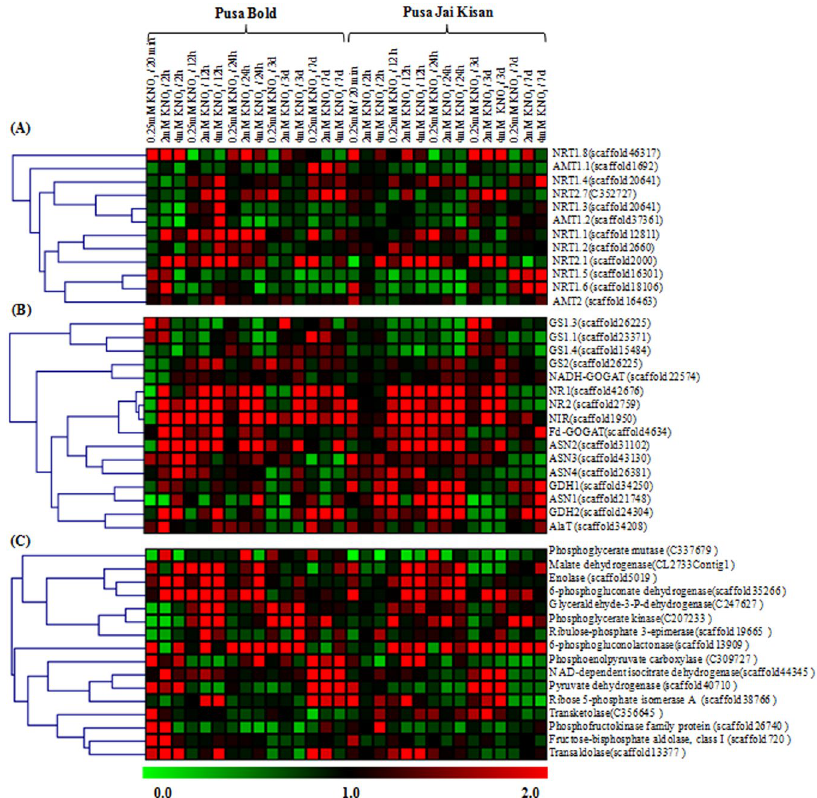
Figure 4. Heat map showing the relative expression of genes of N-uptake ( A ), N-assimilation ( B ) and genes involved in carbohydrate metabolism ( C ) in PB and PJK with respect to control sample of each time point in response to various nitrate treatments. The vertical bar indicates relative expression ratio where red, black and green represents upregulation, no change and downregulation in transcripts